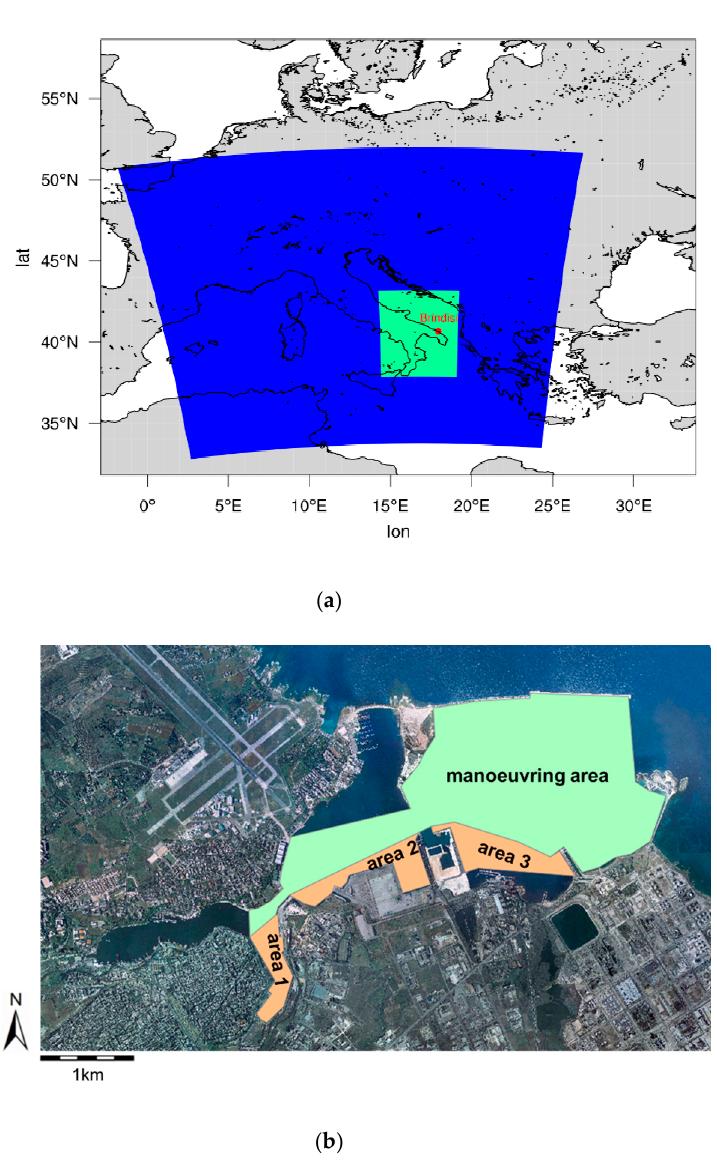
Figure 2. ( a ) BOLCHEM parent domain (in blue) and nested domain (in green); ( b ) ADMS domain with indication of the subdivision of the port into four areas (areas 1, 2, 3: hotelling areas). ADMS-Urban simulations were then performed over a grid of 100 × 100 cells covering